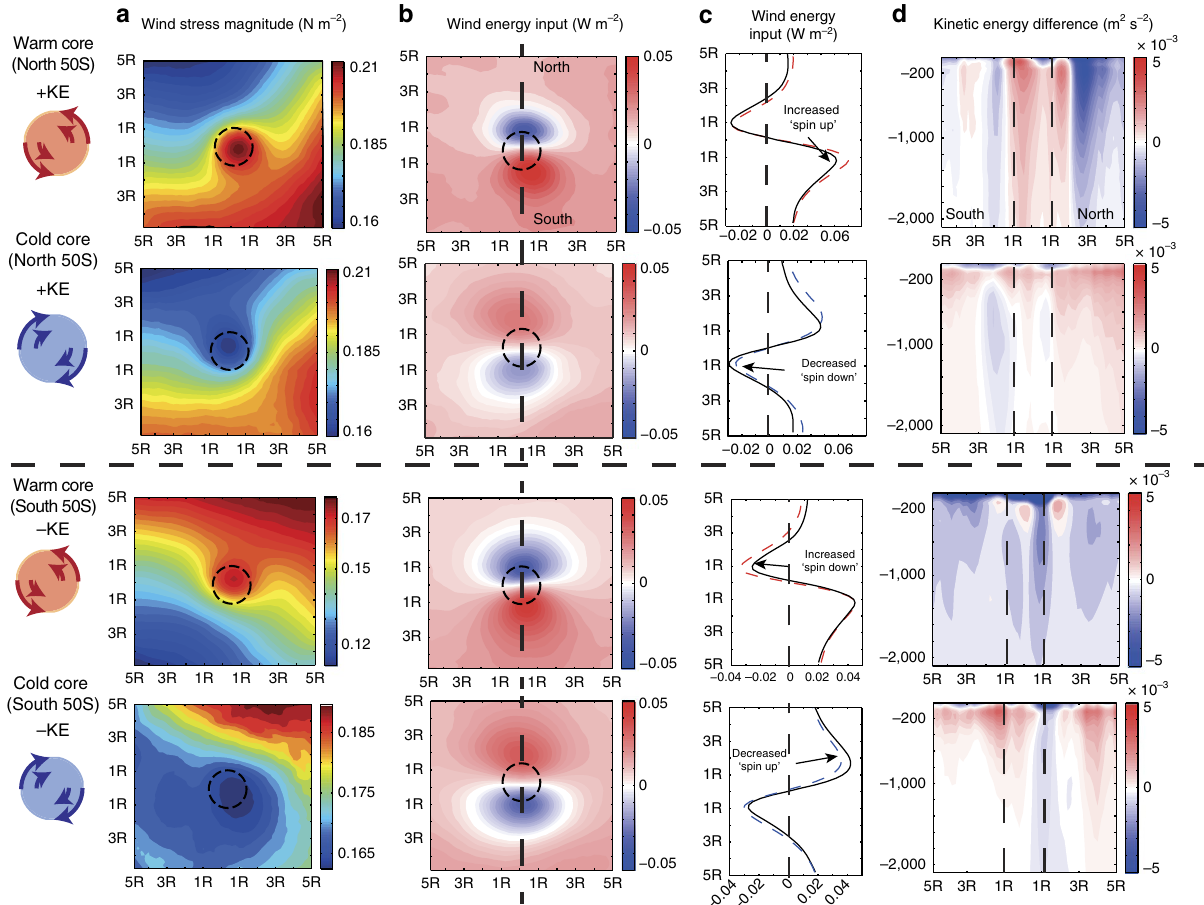
Figure 3 | Model results of the modification of the wind energy transfer at the mesoscale. Composite eddy maps, separated by wind stress gradient (north and south of 50 (cid:2) S) and cold- and warm-core eddies. ( a ) Eddy-induced wind stress change above the eddies from the fully coupled simulation (MFC). ( b ) Wind energy input for the fully coupled simulation showing the dipole structure resulting from the coupling between the ocean and atmosphere; ( c ) wind energy input along the chord (vertical line in b ) separately for the fully coupled (MFC dashed red) and the mechanically coupled simulation (MMC solid black). ( d ) Vertical section of the difference in ocean KE between the fully and mechanically coupled simulation (MFC–MMC) (along the same vertical line in b ), showing an increase for both warm- and cold-core eddies in the northern and a decrease in the southern wind gradient